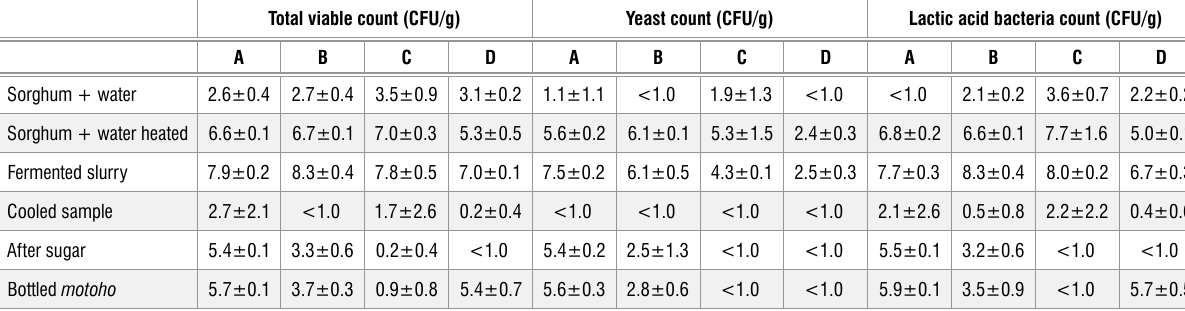
Figure 2: Polymerase chain reaction amplification of 16S rRNA for identification of lactic acid bacteria cultures. Mean microbiological counts (log CFU/g) of the traditional and modified motoho obtained during processing and on various selective media Total viable count